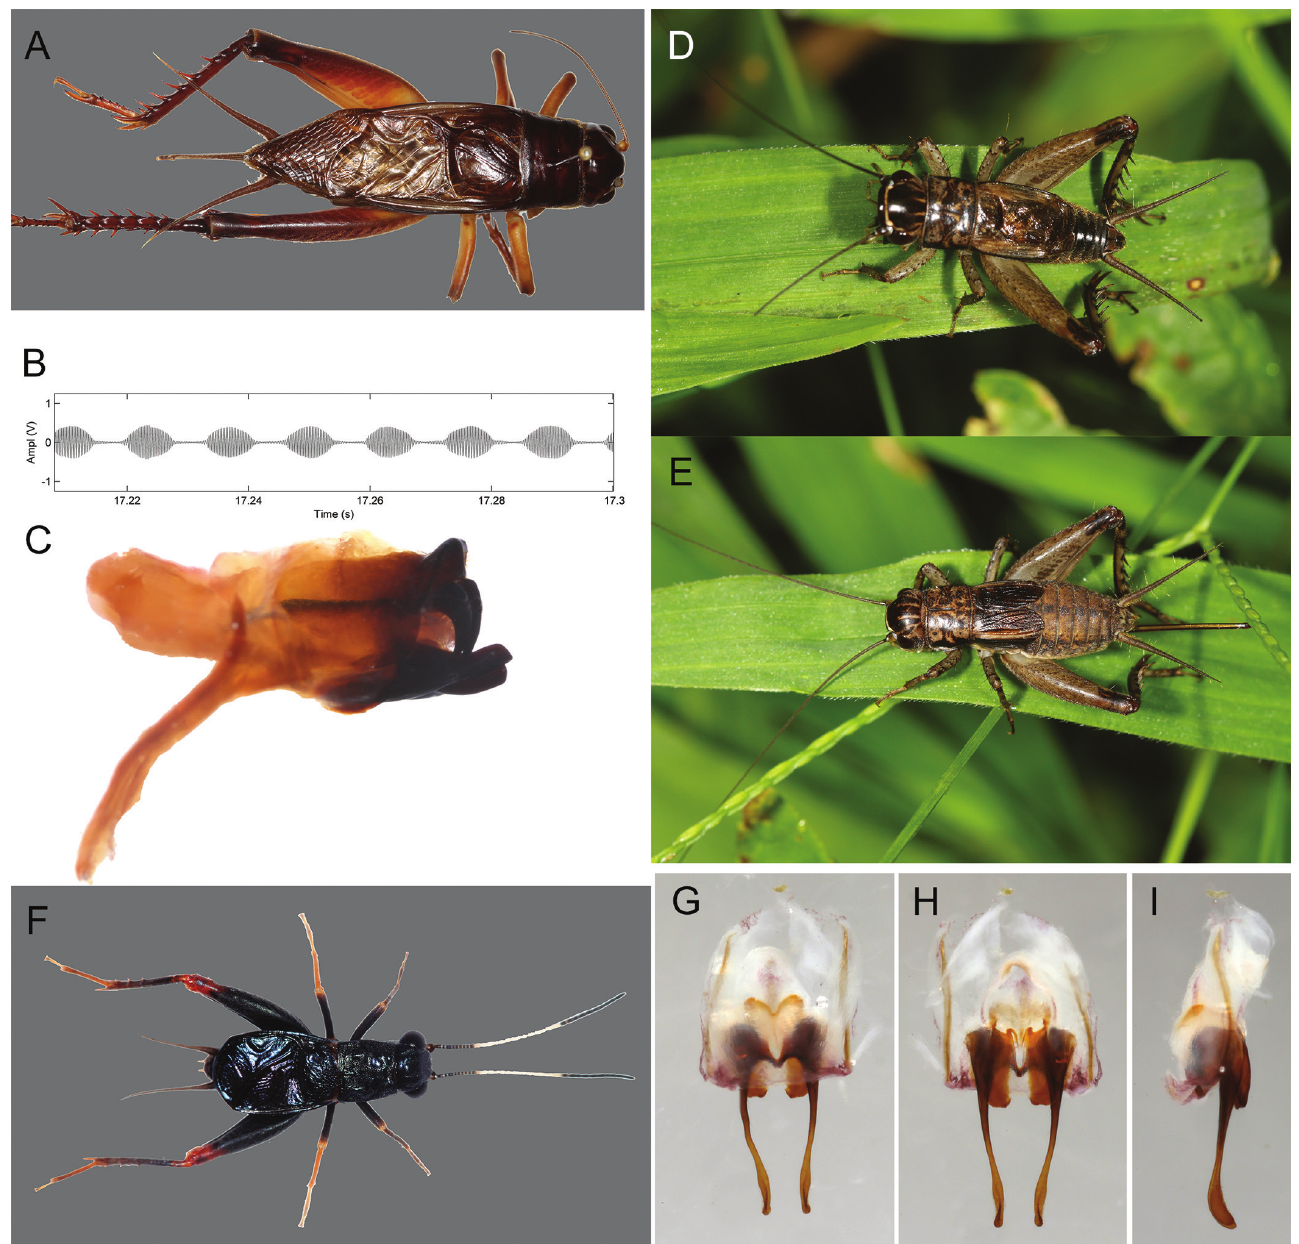
Fig. 9. Gryllidae: Gryllinae: Gymnogryllus unexpectus trusmadi : A. Male; B. Calling song; C. Male genitalia in lateral view; Loxoblemmus sp.: D. Male; E. Female; Mimicogryllus sp.: F. Male; G–I. Male genitalia in ventral, dorsal, and lateral views respectively. 15. Amusurgus or Paratrigonidium